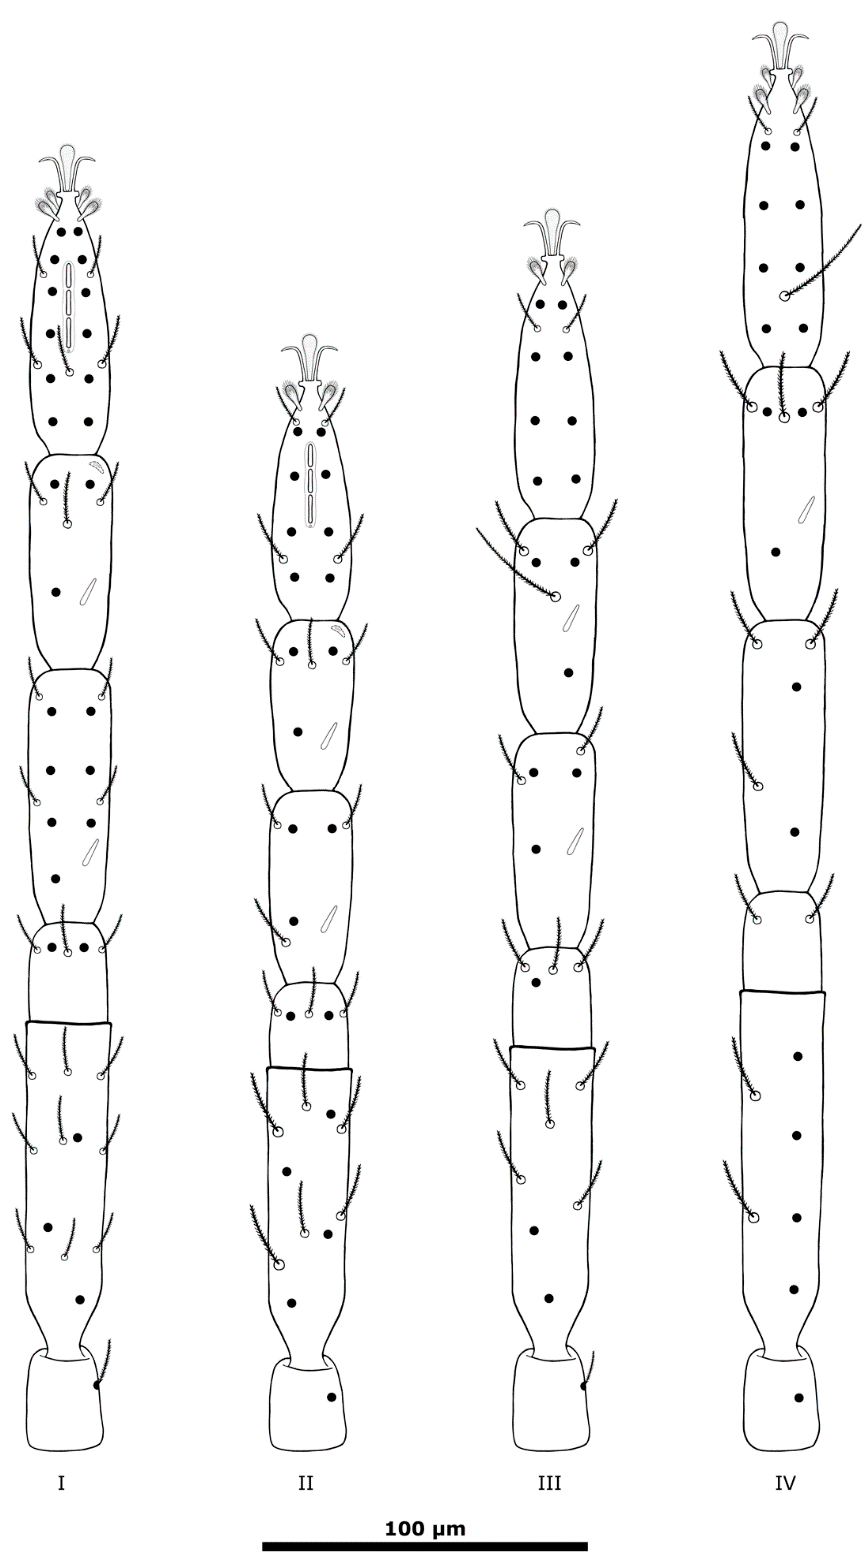
Figure 7. S. nunatakis sp. nov. Leg chaetotaxy; black dots represent the setae on the ventral side; outlines after the drawings of Pittard [2] and arranged with proportions and details of S. nunatakis individuals.